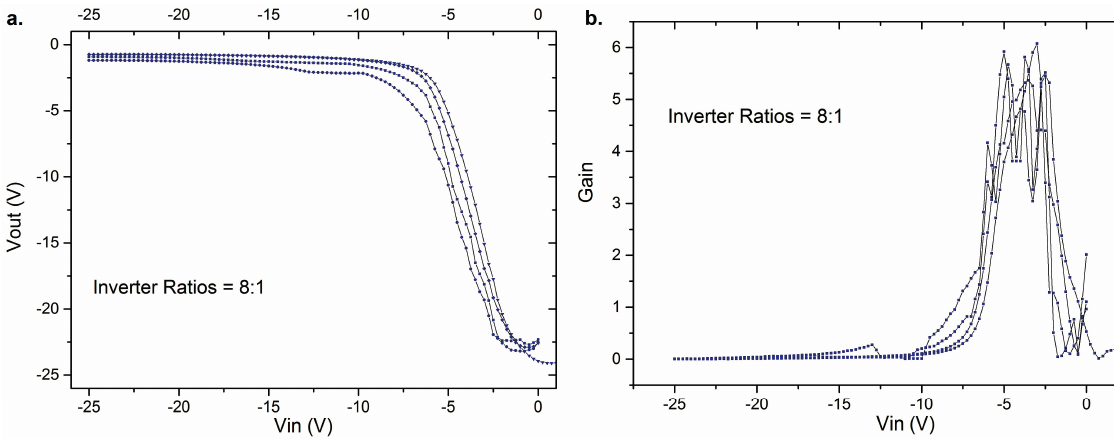
Figure 14. Inverter curve showing the ( a ) switching characteristics and ( b ) the gain plot for 4 inverters in the switching